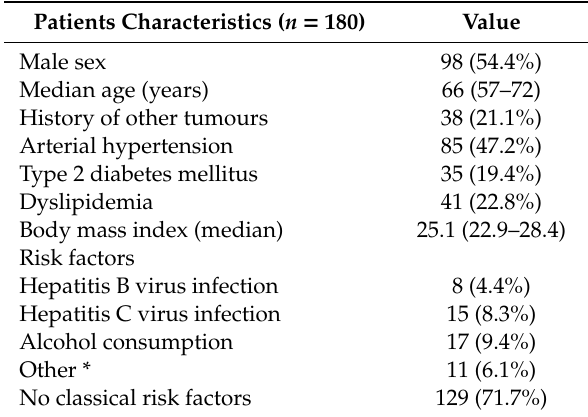
Table 1. Clinical characteristics of the whole study population.